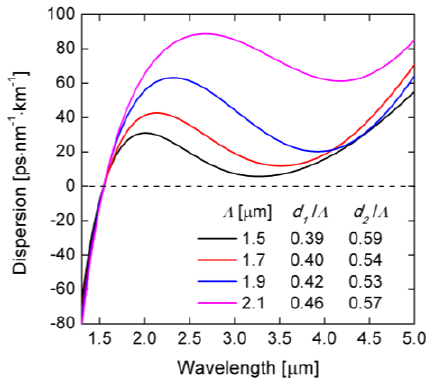
Figure 3. Dispersion characteristics for different lattice constants Λ and different filling factors for the first row of air-holes d 1 / Λ , and for the other rows of air-holes d 2 / Λ .